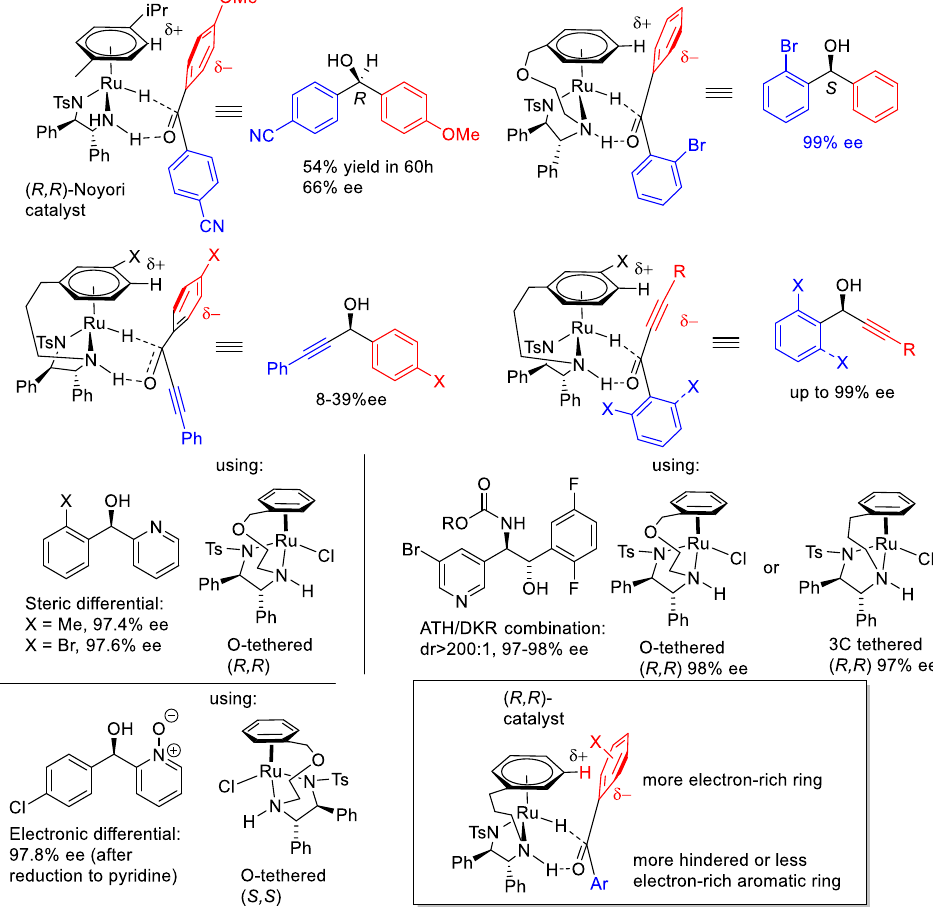
Figure 7. Examples of ATH of benzophenone derivatives and heterocyclic ketones using Noyori– Ikariya catalysts (The red part favours positioning adjacent to η 6 -arene of catalyst, while the blue part favours positioning distal to η 6 -arene of